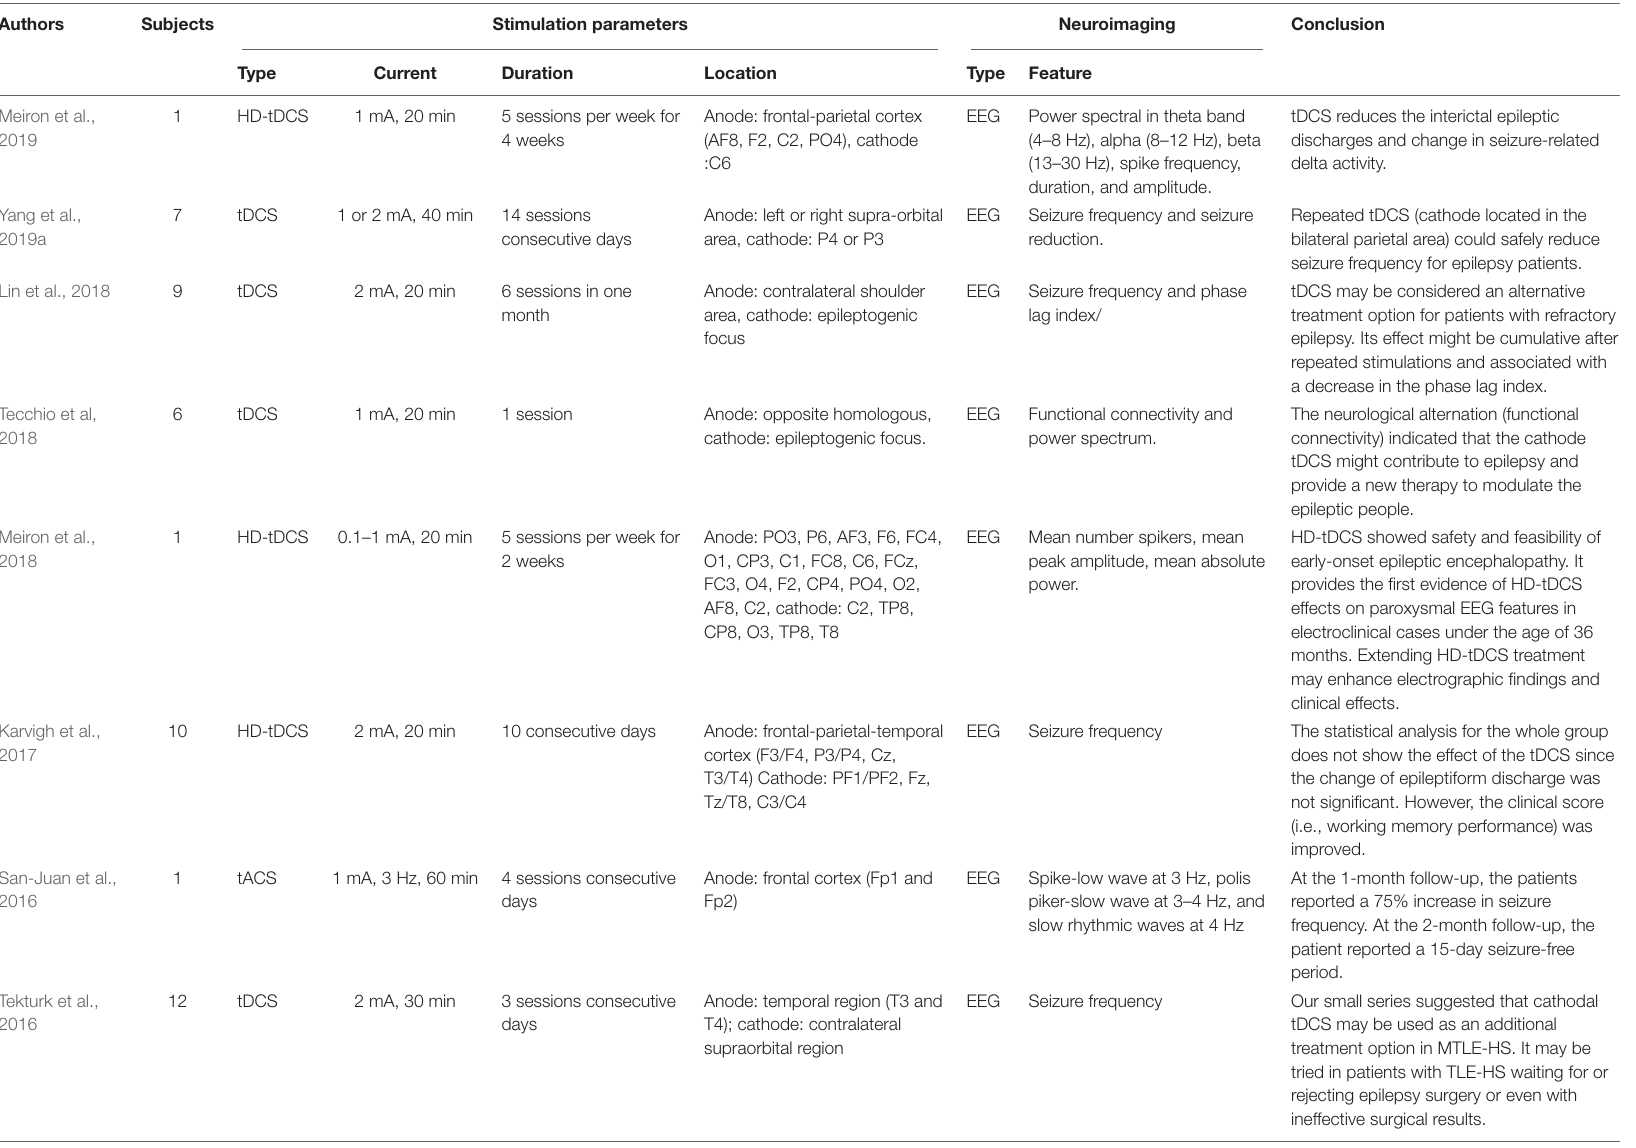
TABLE 5 | Studies and experimental characteristics of tES literature for